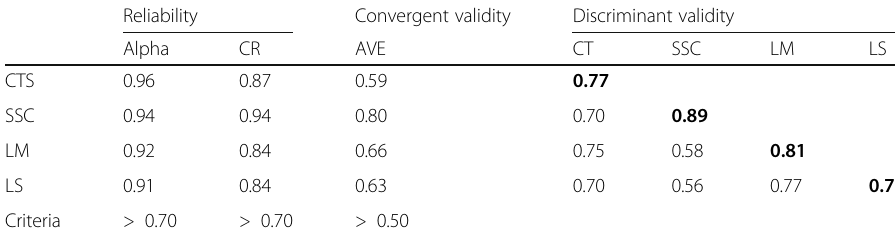
Table 1 Validity and reliability